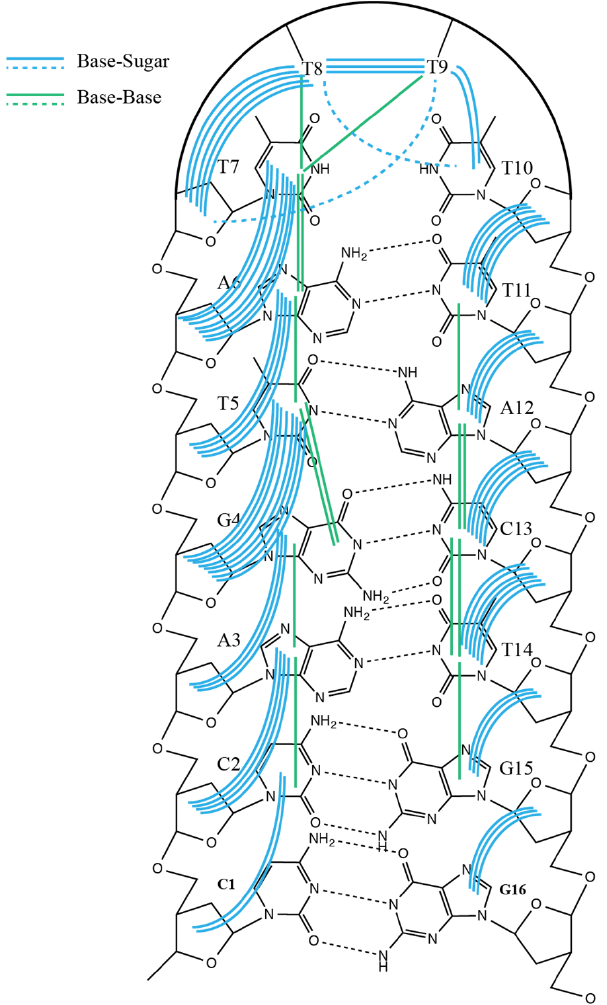
Figure 8. Schematic representation of the inter-base NOE connections for free OL 2 in D 2 O at 25 ◦ C. Base–base (green) and base–sugar (blue). NOE connectivities are shown here with lines and listed in Table S2. Dashed lines are used to avoid confusion in the busy sectors of the